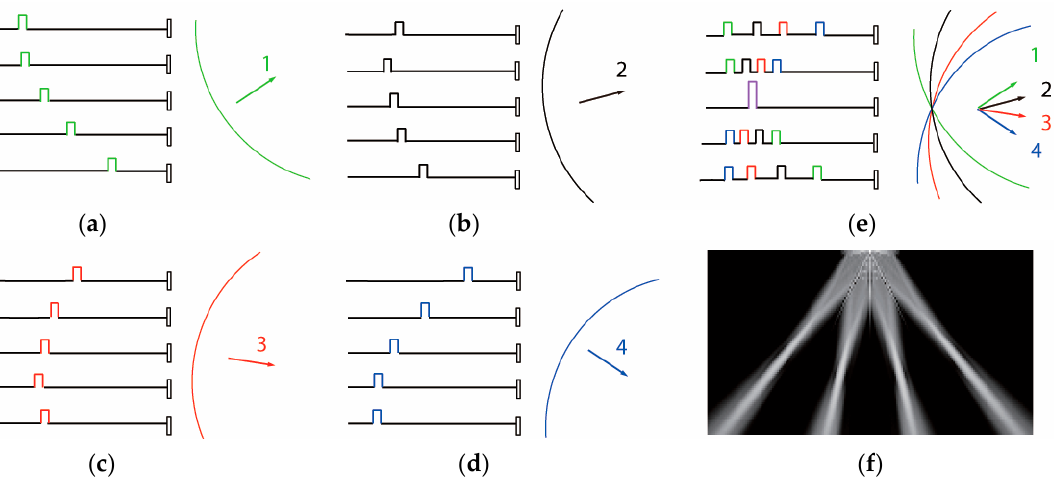
Figure 1. Pulses to be applied on individual elements of a phased array transducer in order to generate four focused transmit beams: ( a ) Transmit direction 1, ( b ) transmit direction 2, ( c ) transmit direction 3, ( d ) transmit direction 4, consecutively, or ( e ) simultaneously; and ( f ) A beam pattern of 4 simultaneously transmit beams.